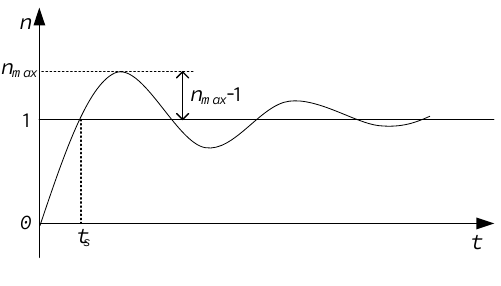
Figure 5. The speed transition curves of PSU.